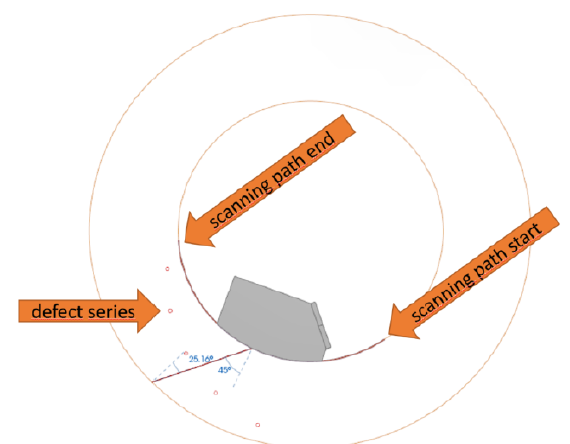
Fig. 5. Geometry in the inspection simulation and defect positions.